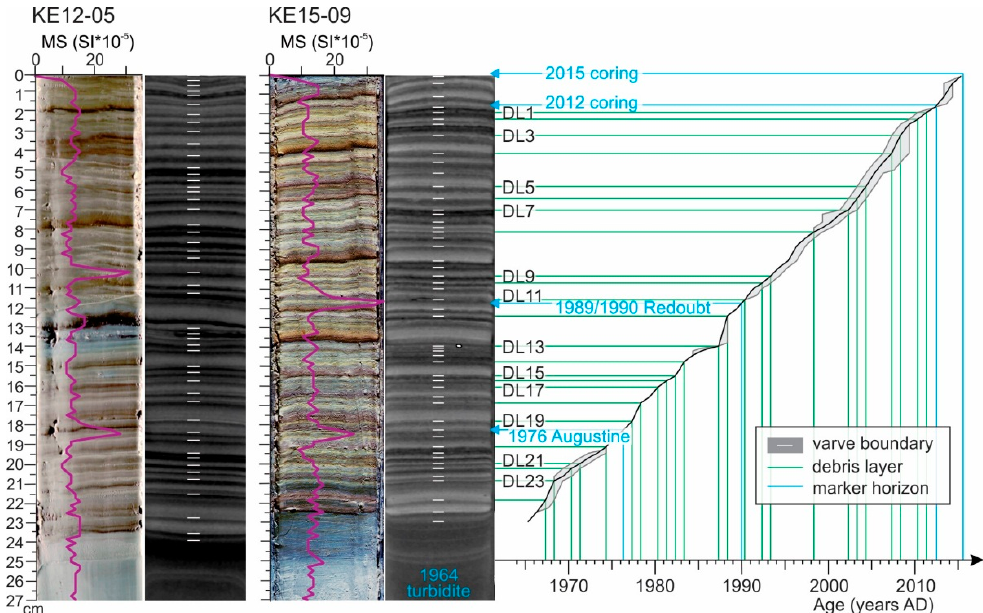
Figure 8. From left to right: Original varve chronology (white lines) of Kenai Lake by Boes et al. [13]. Updated varve chronology based on two cryptotephra layers (lower blue lines). Age–depth model of core KE15-09. For each debris layer (DL; green lines) (y-axis) the age can be found on the x-axis.